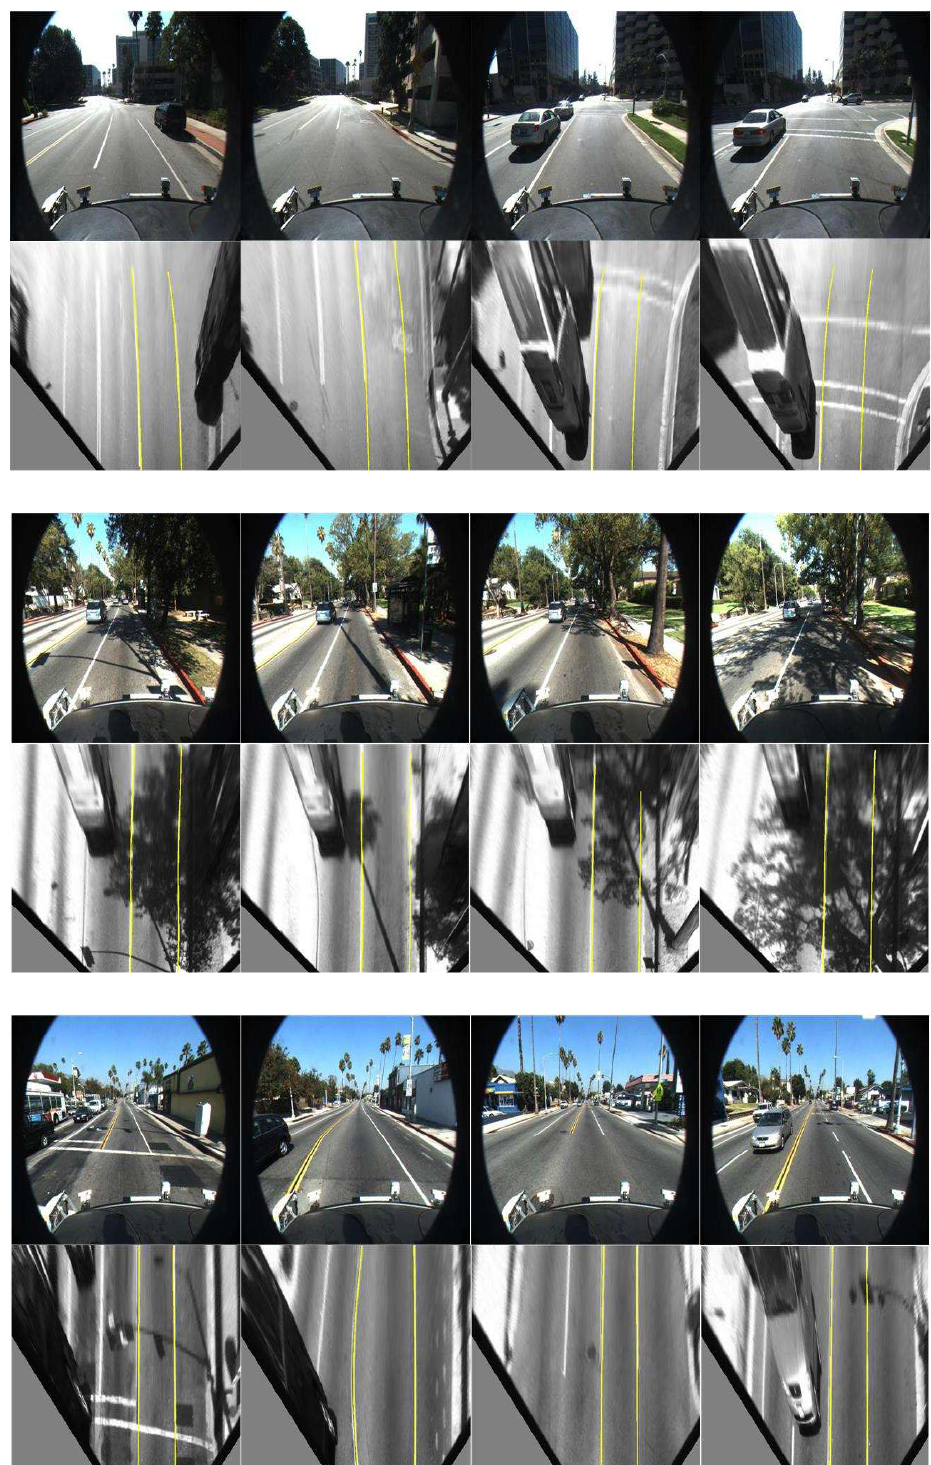
Figure 15. Detection results of the proposed method.